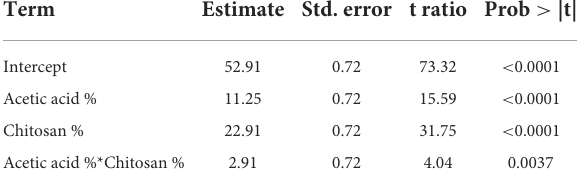
TABLE 9 Estimation of mathematical model parameters of the experimental design related to the firmness of the